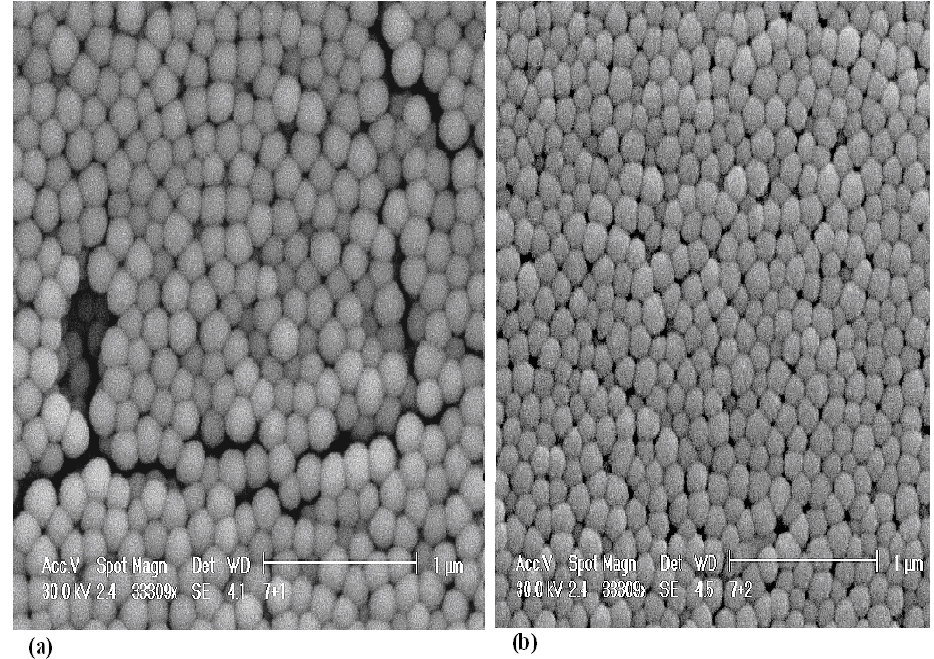
NPs for ( a ) t1 and ( b ) t2 2